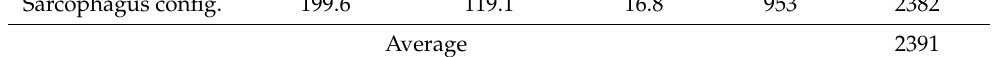
Figure 8. Edge-on impact set-up in open configuration considered in the present study. Table 3. Initial dimensions and calculated density of the samples tested in the EOI configuration. Height (mm) Width (mm) Open config. 198.8 Sarcophagus